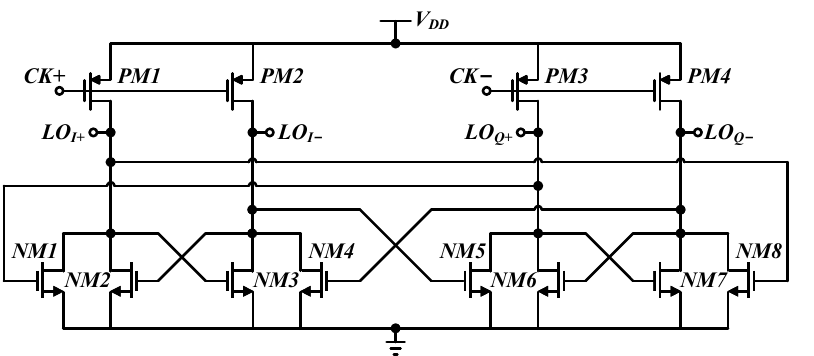
Figure 6. The 25% duty-cycle clock generation directly after the divide-by-2 frequency divider.